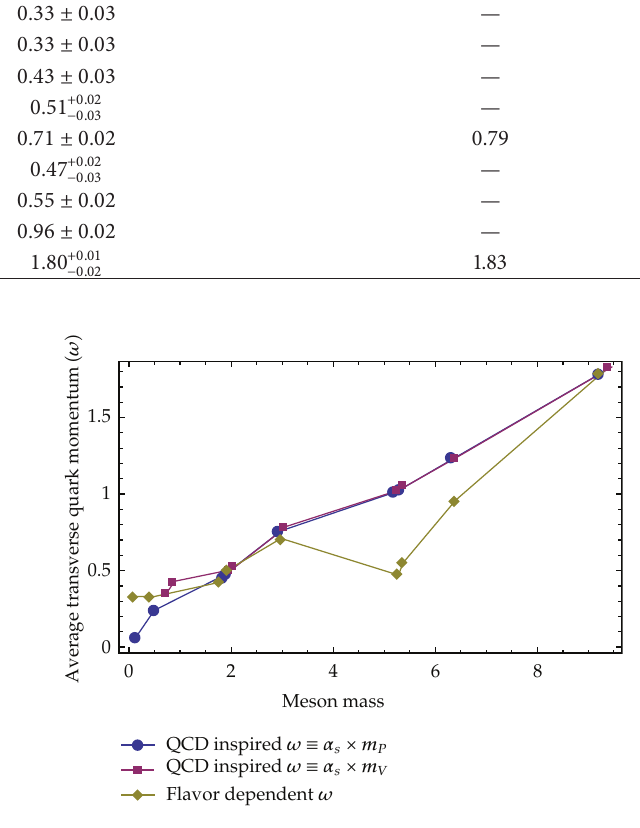
Figure 1: Variation of average transverse quark momentum with respect to physical meson masses.